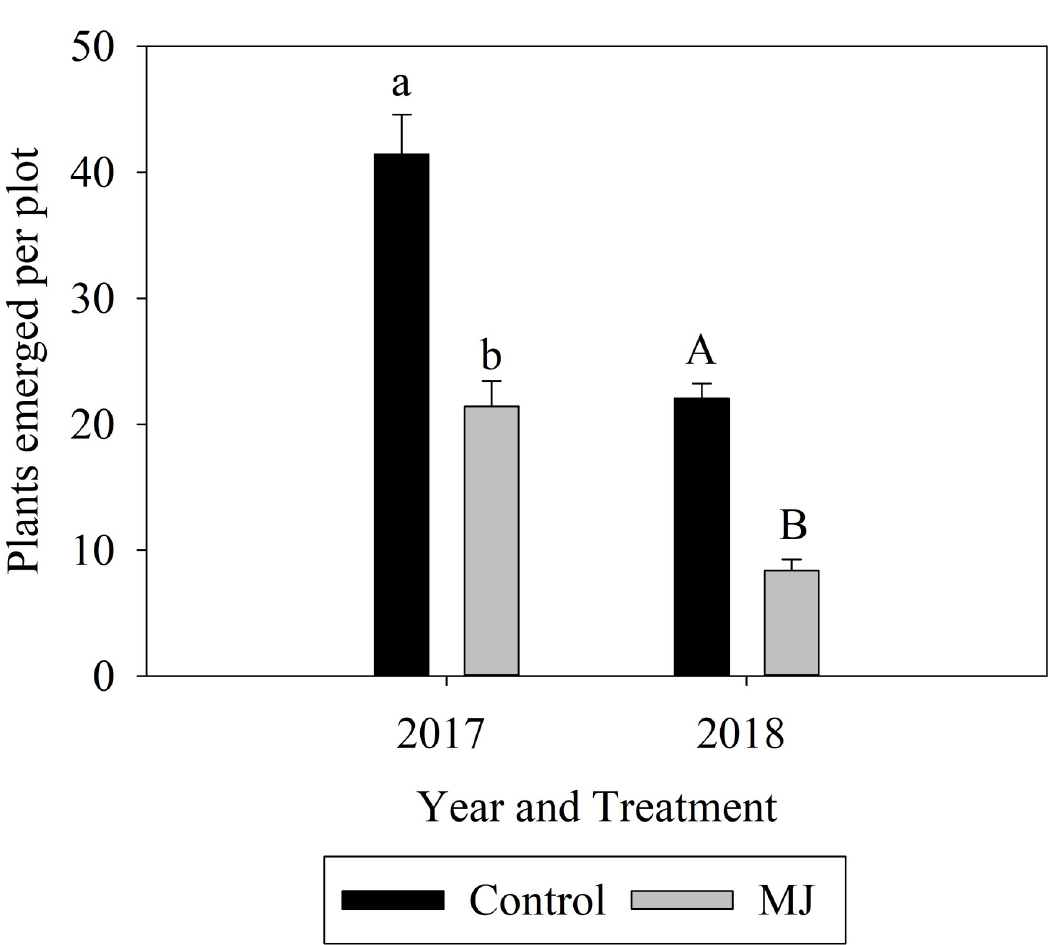
Fig 3. Effects of treatment of rice seeds with methyl jasmonate (MJ) at a concentration of 2.5 mM on numbers of emerged rice seedlings in a 0.09m 2 area (numbers of plants ± SE). Pooled data from 14 and 17 days after seeding in 2017 and 12 and 22 days after seeding in 2018 are shown. Bars accompanied by different letters represent means that differed significantly by Tukey’s HSD test at α <